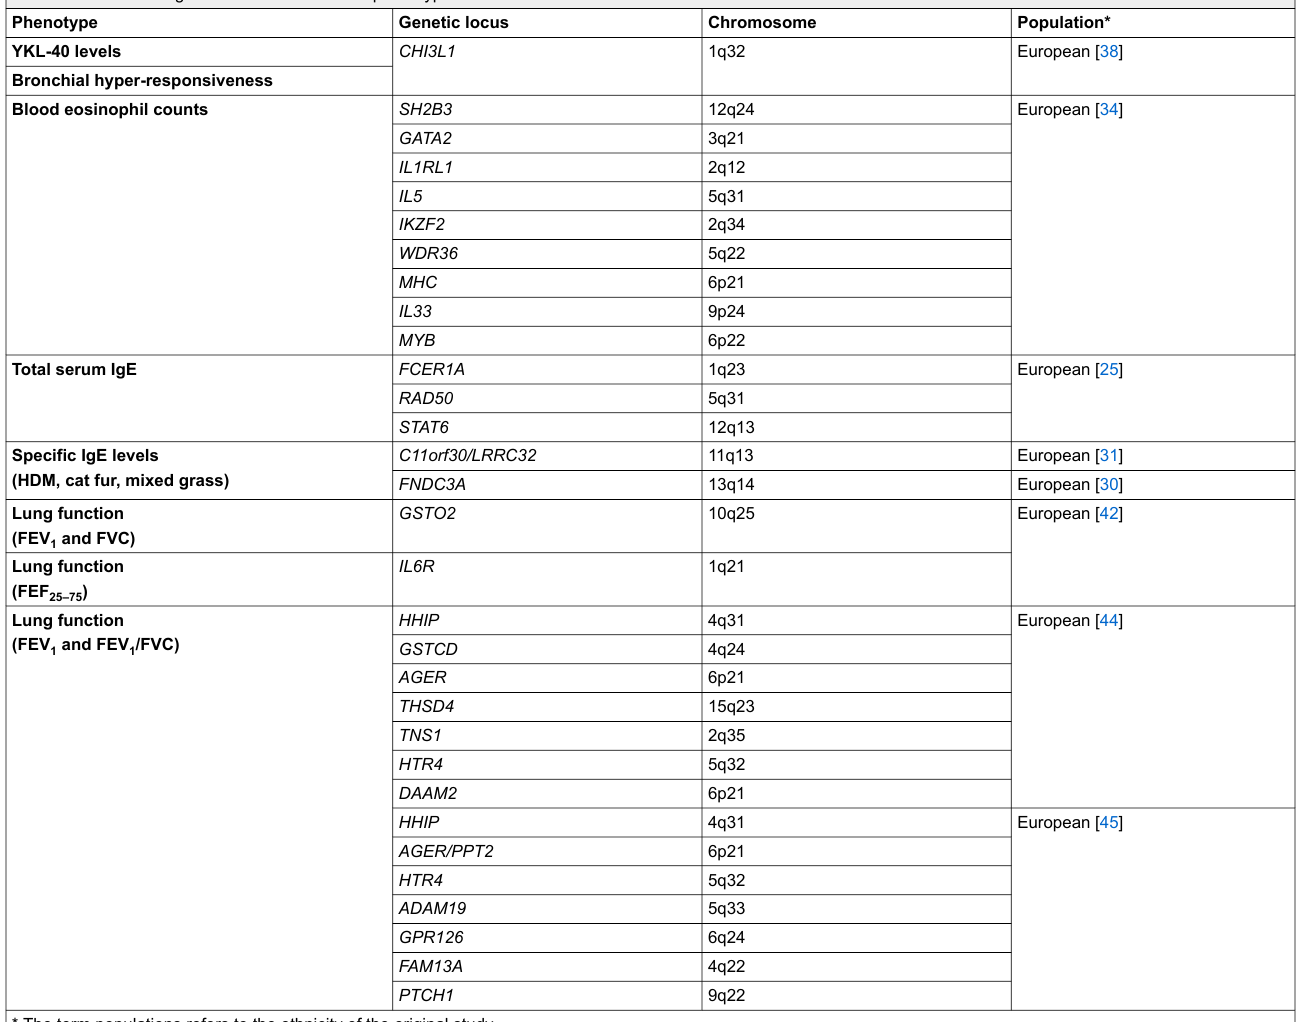
Table 1: GWAS findings in intermediate asthma phenotypes.